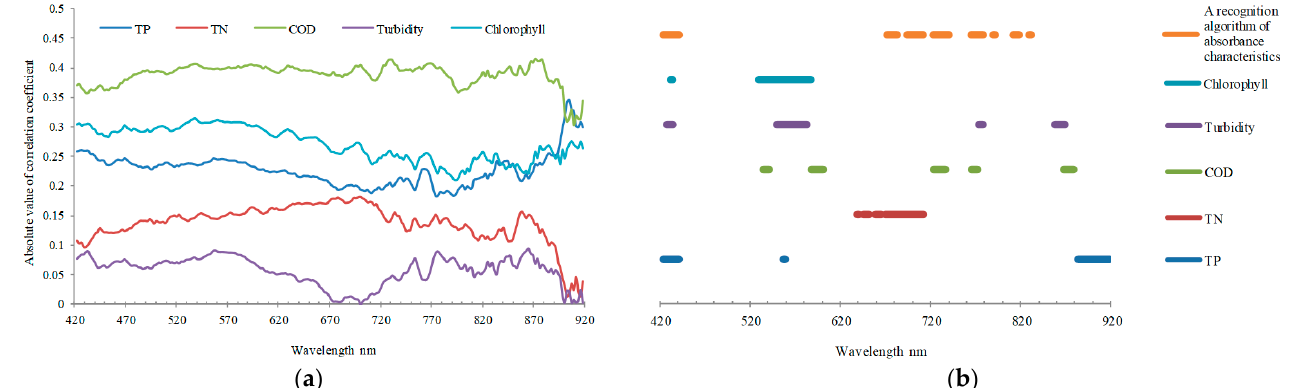
Figure 10. The water quality parameters characterization band set. ( a ) The absolute value of corre- lation coefficient between five water quality parameters and all bands; ( b ) the comparison chart of characteristic bands selected by supervised method and unsupervised method.